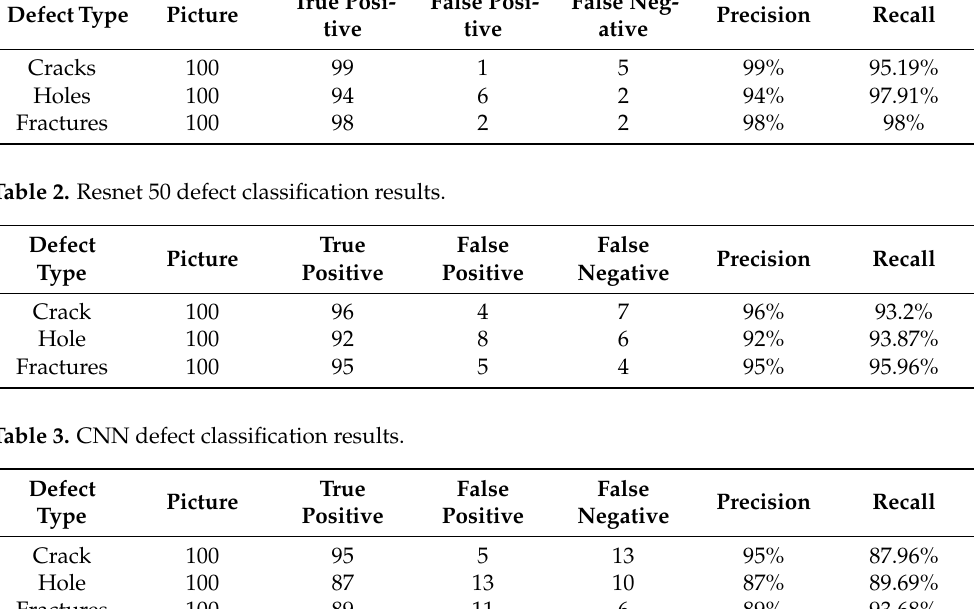
Figure 14. Comparison of three algorithms confusion matrix. Table 1. VGG16 defect classification results.